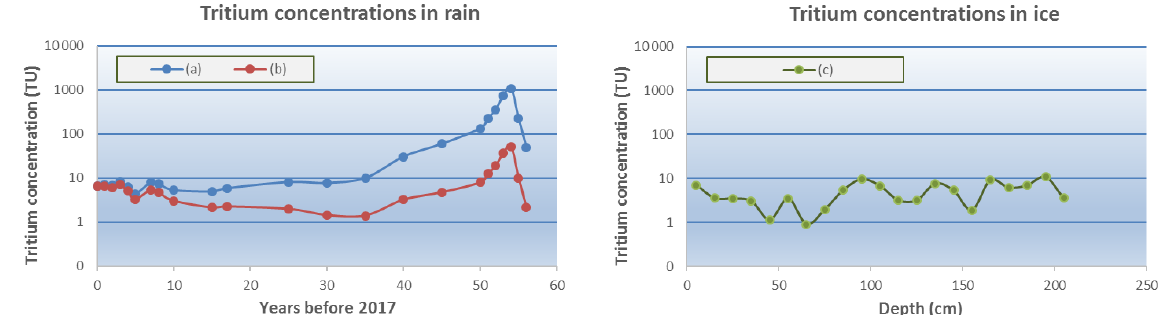
Figure 3. Tritium concentration: the blue line (a) shows the annual mean values of tritium in rain samples from various monitoring stations in Greece (GNIP, IAEA, see Fig. 1 for the sites of the stations and Table S3 for the coordinates and altitude). The red line (b) shows the annual mean tritium values of line (a) corrected for decay at the year of ice sampling (2017). The green dots (c) show the tritium content in ice samples of odd numbering with depth, from the Christaki